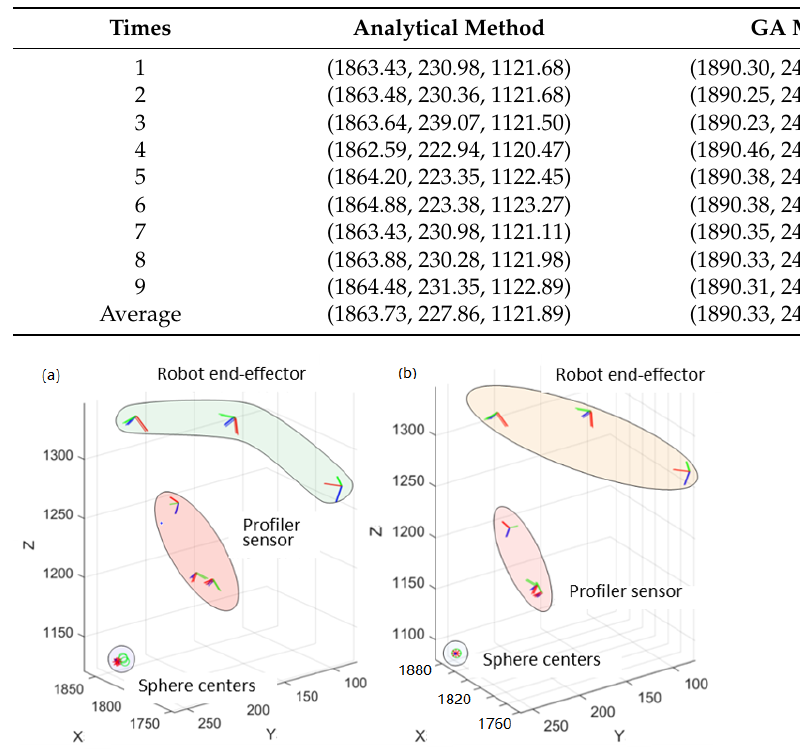
Figure 5. Calculated sphere centers results; ( a ) analytical method; ( b ) GA